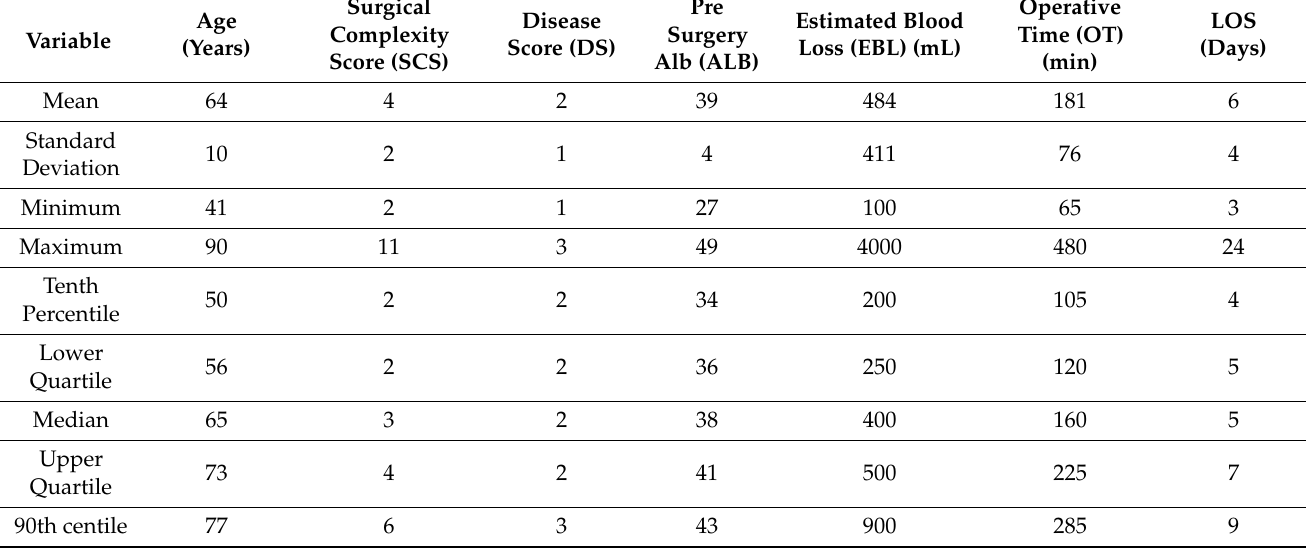
Figure 2. Histograms of the residual length of stay (LOS) distribution of advanced-stage HGSOC patients following their cytoreductive surgery for the: ( A ) training ( B ) test samples. Residual LOS is the difference between the observed LOS values and the model-predicted LOS values.